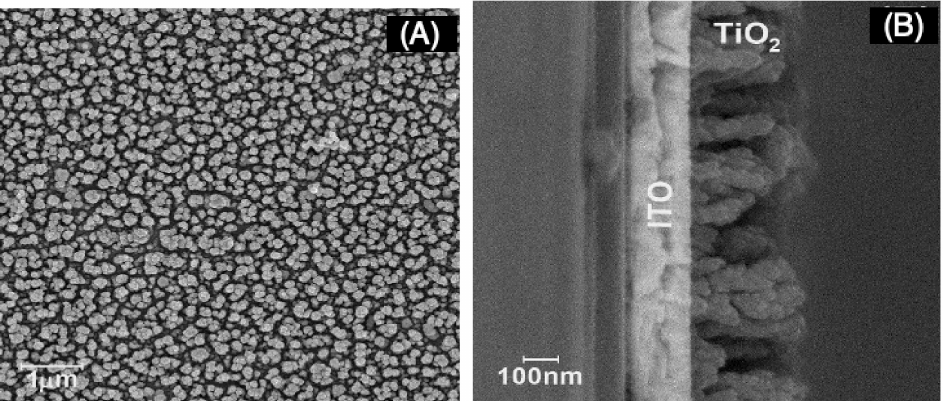
Figure 2. Scanning electron microscopy (SEM) micrographs of indium-doped tin oxide (ITO)|TiO 2 after 300 s electrosynthe- sis time ( A ) top view and ( B ) cross section.